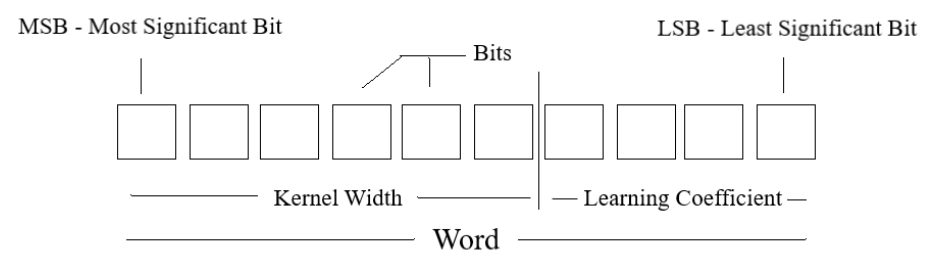
Figure 5. Individuals from the initial